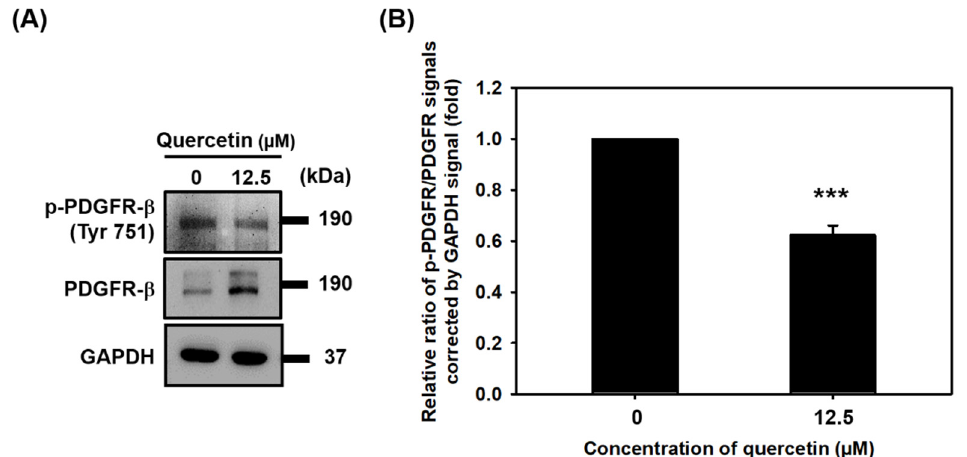
Figure 6 . Quercetin inhibited phosphorylation of PDGFR- β . C2C12 cells were grown to 80% conflu- ency density in a 24-well plate. The cells were untreated or treated with quercetin (0, 12.5 μ M) and cultured in DMEM medium containing 2% horse serum to promote cell differentiation for 7 days. ( A ) Western blot was used to study the effect of quercetin on protein expression of p-PDGFR and PDGFR, with GAPDH used as internal control. ( B ) Bar graph shows the quantified relative protein expression of p-PDGFR and PDGFR. Data are expressed as mean ± SD based on three independent biological repeats ( n = 3). A significant difference was found between the quercetin-treated group and controls, *** p < 0.001.